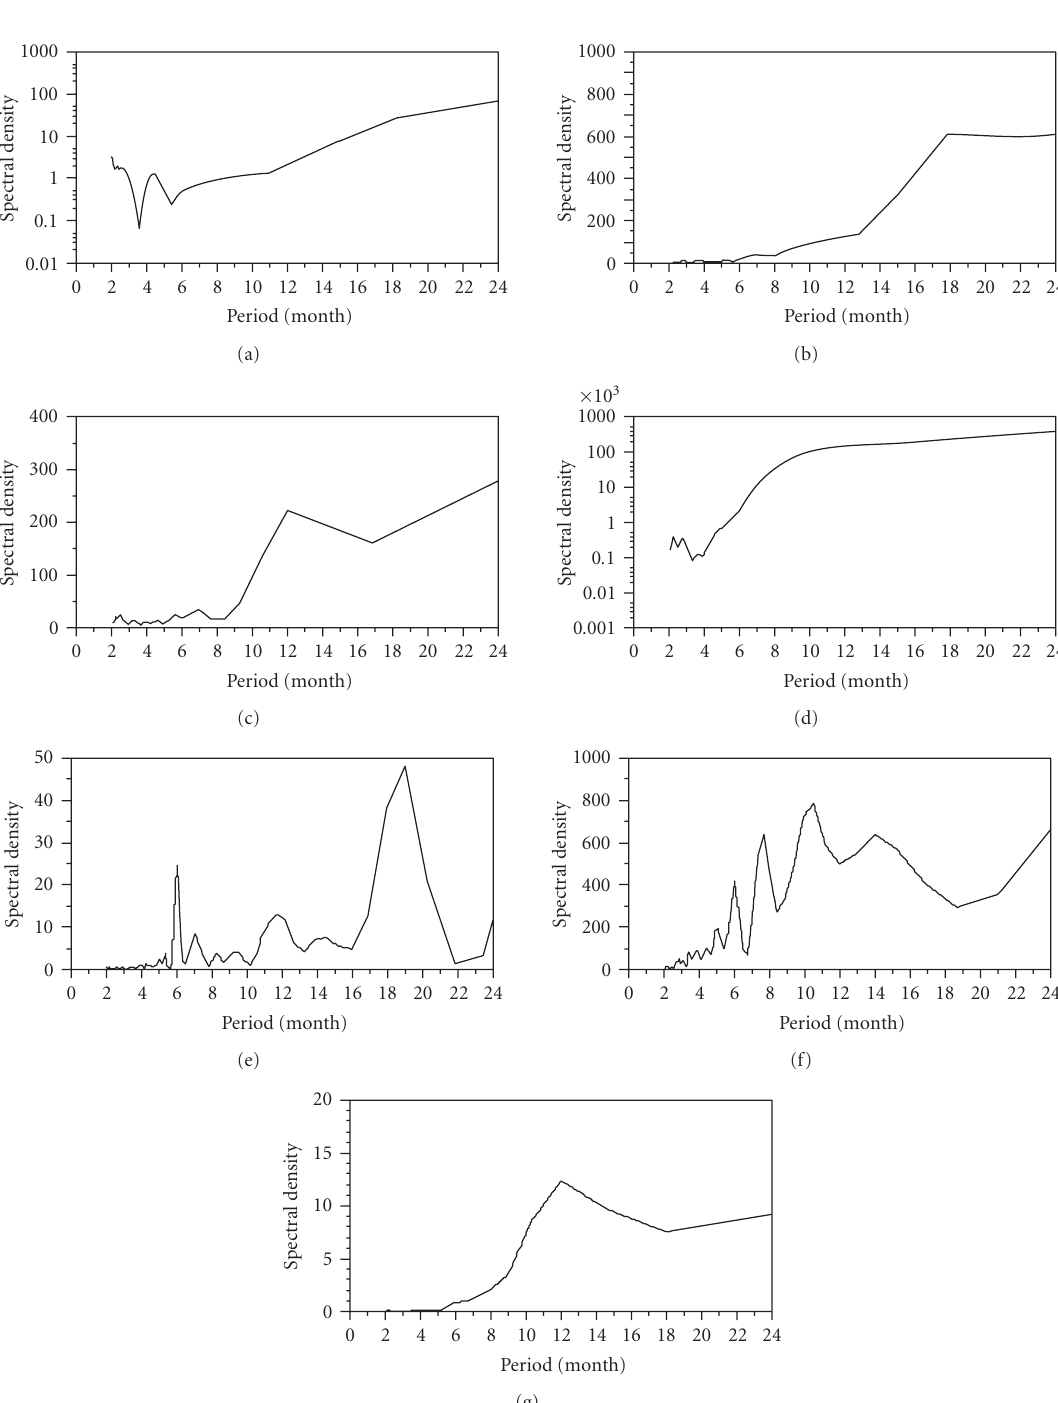
Figure 2: The spectral density plots for smallpox occurrences . (a)–(f) correspond to locations as chronologically ordered in Figure 1. A sharp peak at a period of 12 months corresponds to the annual cycle (seasonality), while other longer peaks may reflect a super-annual cycle (periodicity). No adjustment was made in drawing the